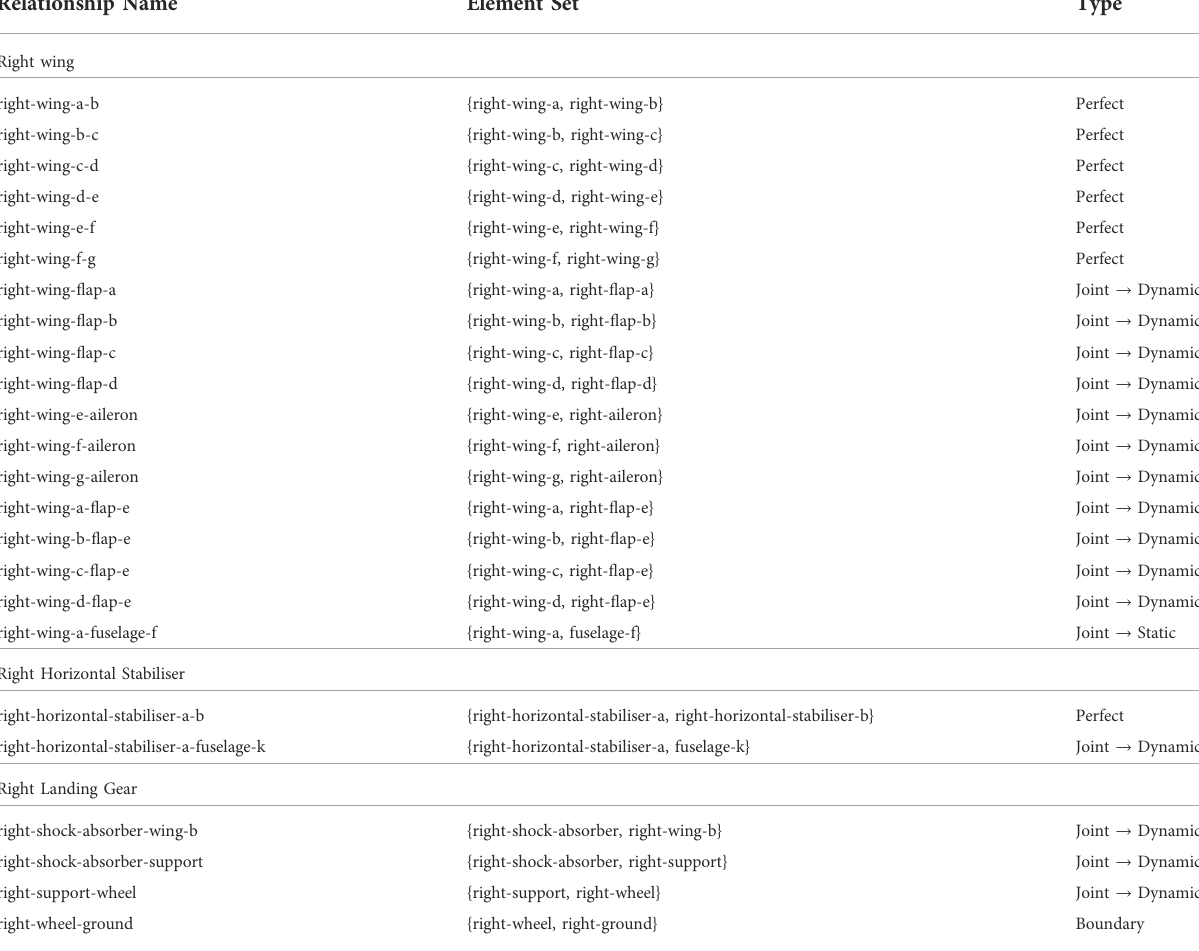
TABLE7RelationshipsfortheRightWing,HorizontalStabiliser,andRightLandingGearofthegeneralised HawkT.Mk1.SeeSection6.1.2andSection 6.2.2 for the Left and Center